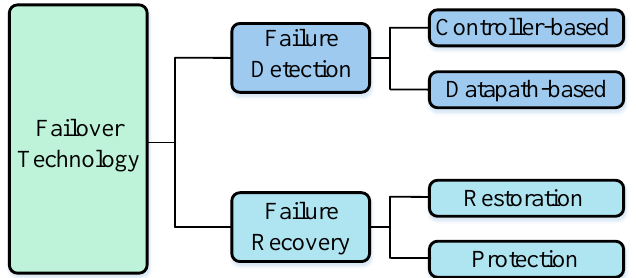
Figure 2. Classification of failover technology in data plane of Software-Defined Networking